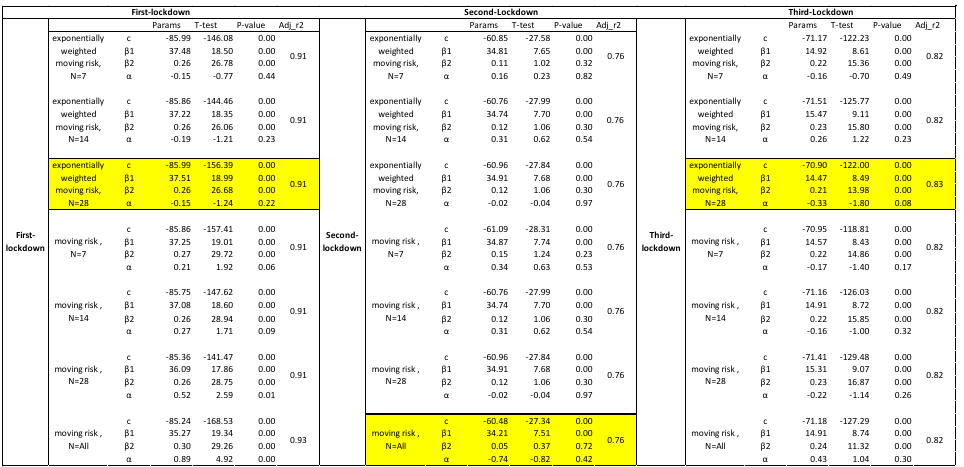
Figure A4. The nonlinear model results of each generated risk perceptions in three lockdown periods.